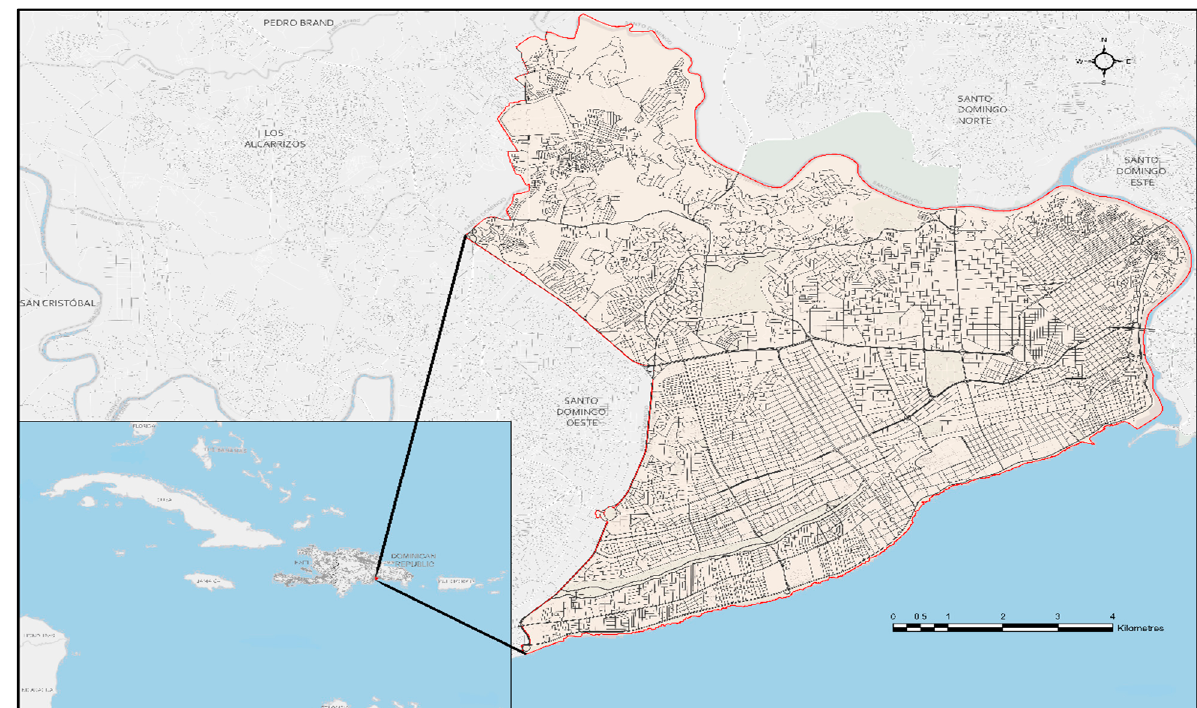
Figure 1. National District Location, Santo Domingo, Dominican Republic.